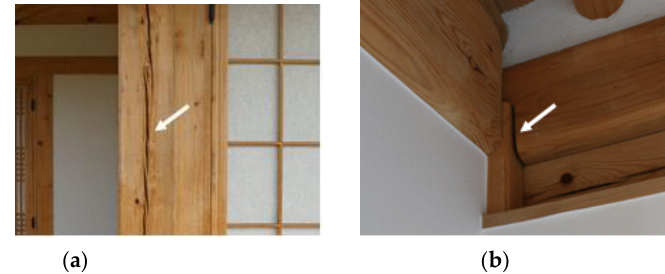
Figure 8. Hanok defects: parallel twists and joint fissures. ( a ) Parallel twists; ( b ) Joint fissures